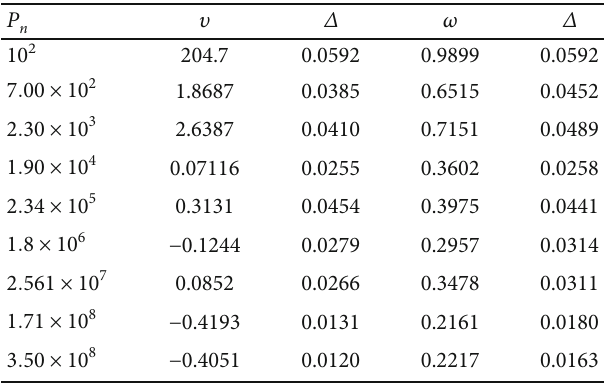
Figure 8: (NNSD) for continuous sequences of unfolded primes using (a) 100 primes, (b) 700 primes, (c) 2300 primes, (d) 1 : 90 × 10 4 primes, (e) 2 : 34 × 10 5 primes, (f) 1 : 80 × 10 6 primes, (g) 2 : 561 × 10 7 primes, (h) 1 : 71 × 10 8 primes, and 3 : 50 × 10 8 primes. The curves show the best fi t calculated using the inverse χ 2 distribution Equation (3) and the Brody distribution Equation (7). Table 4: The fi t parameters and absolute average deviation for the accumulated prime sequences shown in Figure